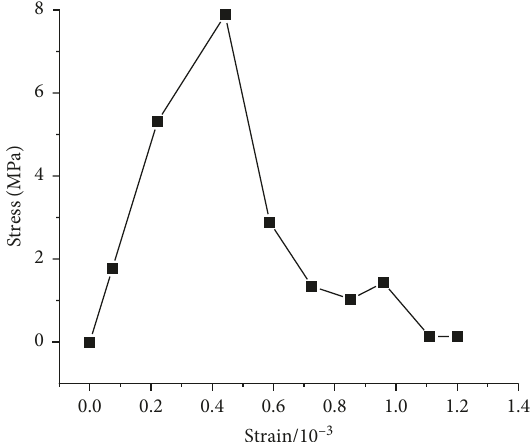
Figure 8: The stress-strain curve of Pull.